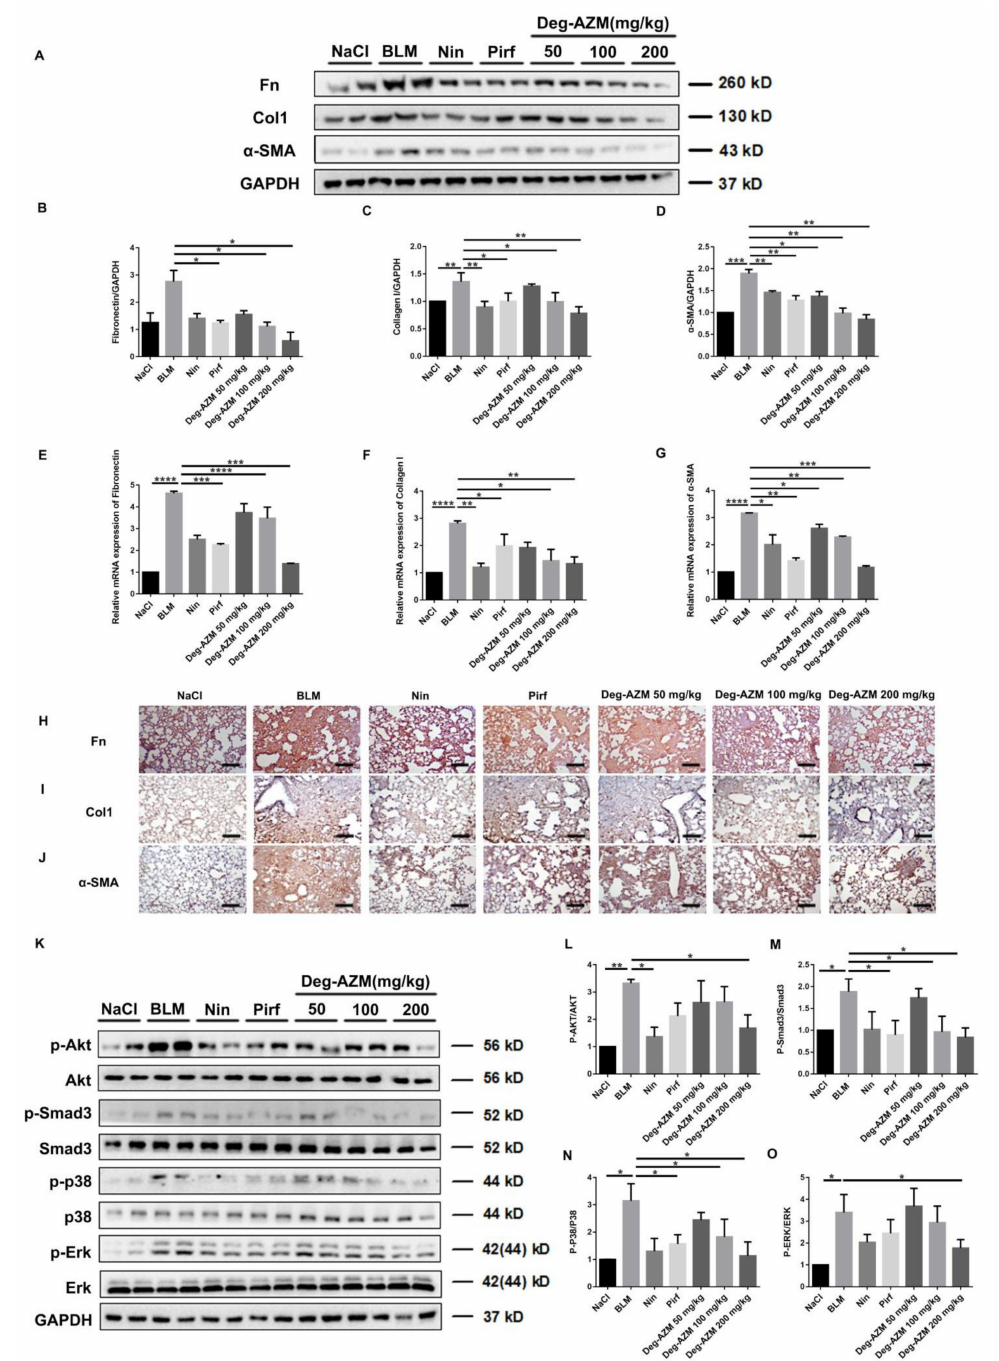
Figure 7. Deglycosylated azithromycin inhibits the fibrogenic activation of pulmonary fibroblasts in vivo . ( A ) Western blot analysis of the protein levels of Fn, Col1 and α -SMA in lung tissues. ( B – D ) Densitometric analysis of Fn, Col1 and α -SMA, using GAPDH as the internal reference. ( E – G ) Real-time PCR was performed to detect the mRNA levels of α -SMA, Col1 and Fn in lung tissues. ( H – J ) Immunohistochemical staining of α -SMA, Col1 and Fn in lung tissues. Scale bar = 50 µ m. ( K ) Western blot analysis of the protein levels of p-Akt, p-Smad3, p-p38 and p-Erk1/2 expression. ( L – O ) Densitometric analysis of p-Akt, p-Smad3, p-p38 and p-Erk1/2 normalized to Akt, Smad3, p38 and Erk1/2 levels, respectively. Data are presented as the means ± SD ( n = 8). Comparisons between groups were achieved using one-way analysis of variance (ANOVA). * p < 0.05, ** p < 0.01, *** p < 0.001, **** p <